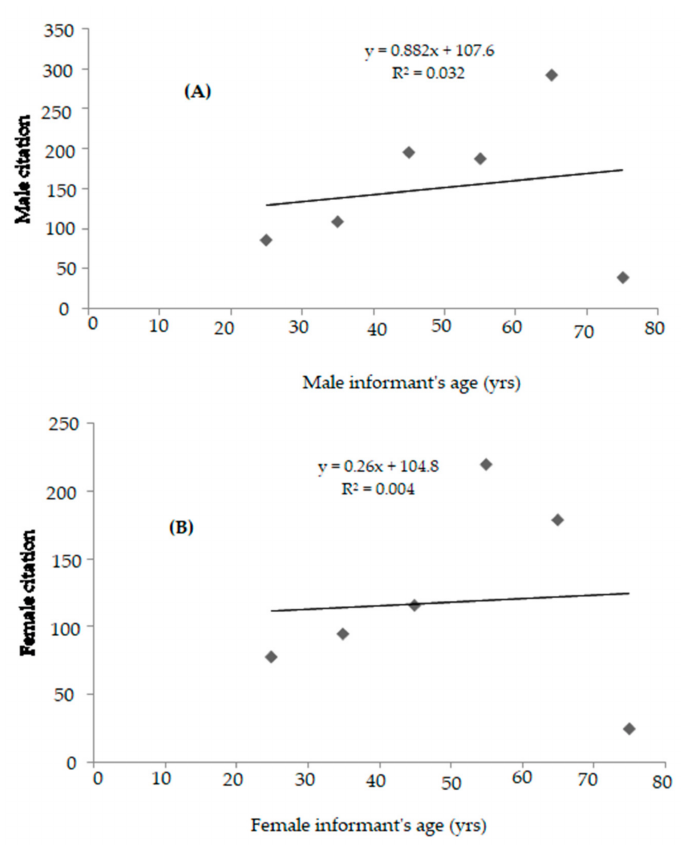
Figure 5. ( A , B ) Linear correlation—relative knowledge (use-reports) of informants vs. age of informants; ( A ) male informants, ( B ) female